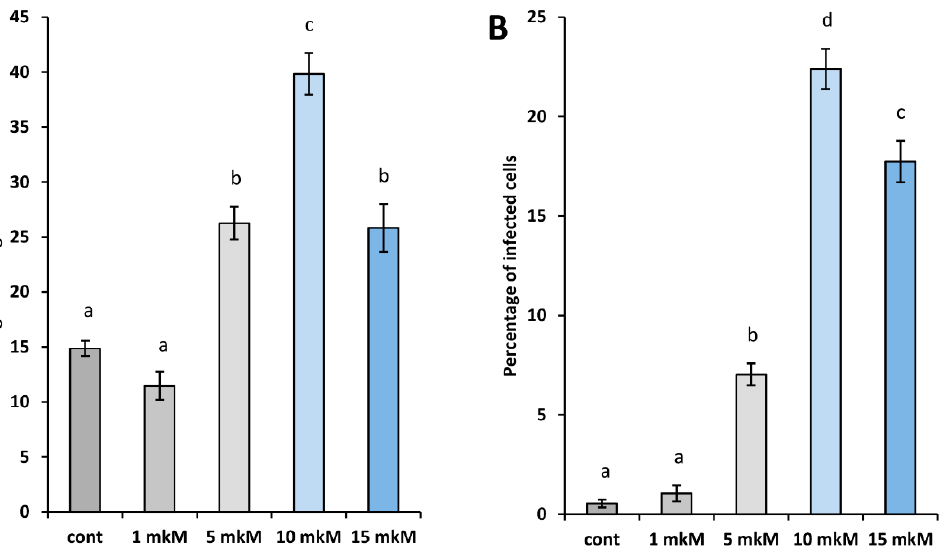
Figure 3. The number of overgrown infection threads ( A ) and percentage of infected cells ( B ) in nodules of sym33-3 mutant plants non-treated (control) or treated with increasing concentrations of cytokinin 6- BAP: 1 μM, 5 μM, 10 μM, and 15 μM. The graphs represent the average values for 15 sections obtained from 5 nodules in each variant. The error bars represent standard errors of the mean (SEM) of all repeats. The different letters indicate statistically significant differences based on ANOVA, followed by Tukey post-hoc test.